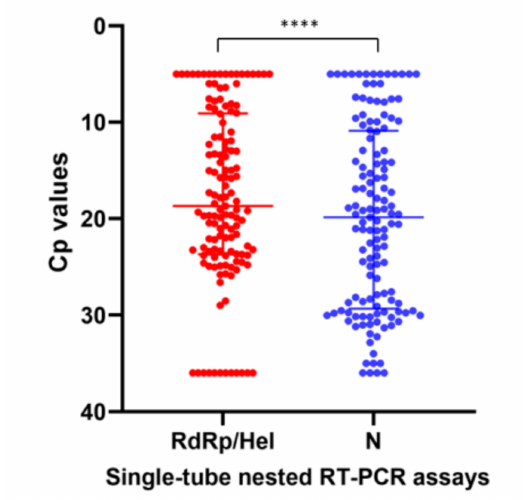
Figure 2. Comparison of the Cp values of the two STN RT-PCR assays in this study. A Cp value of 36 was assigned to specimens that tested negative in the STN RT-PCR assays. **** indicates p <